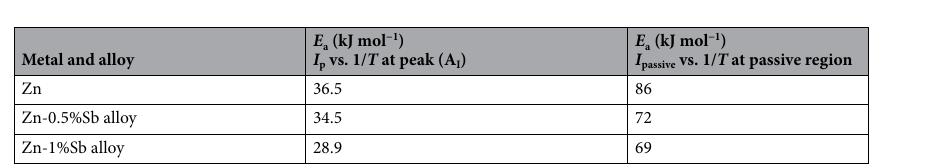
Table 1. Apparent activation energy values of Zn and Zn-Sb alloys calculated from potentiodynamic anodic polarization curves at different temperatures in 6 M KOH solution.